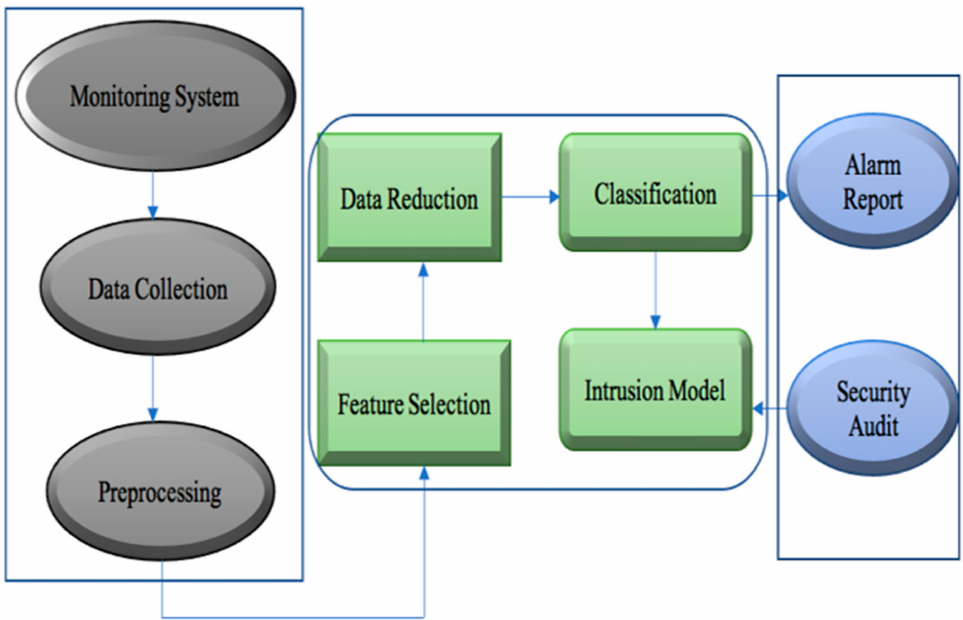
Figure 1. Schematic Representation of